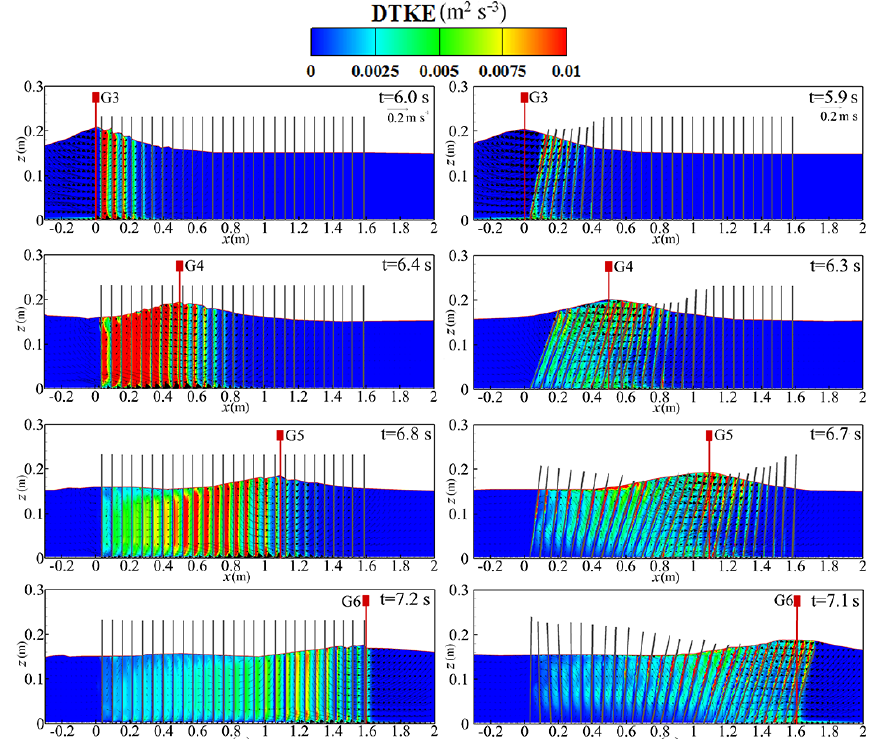
Figure 12. Snapshots of DTKE for stationary cylinders (left) and moving cylinders (right), H i = 0.05m.